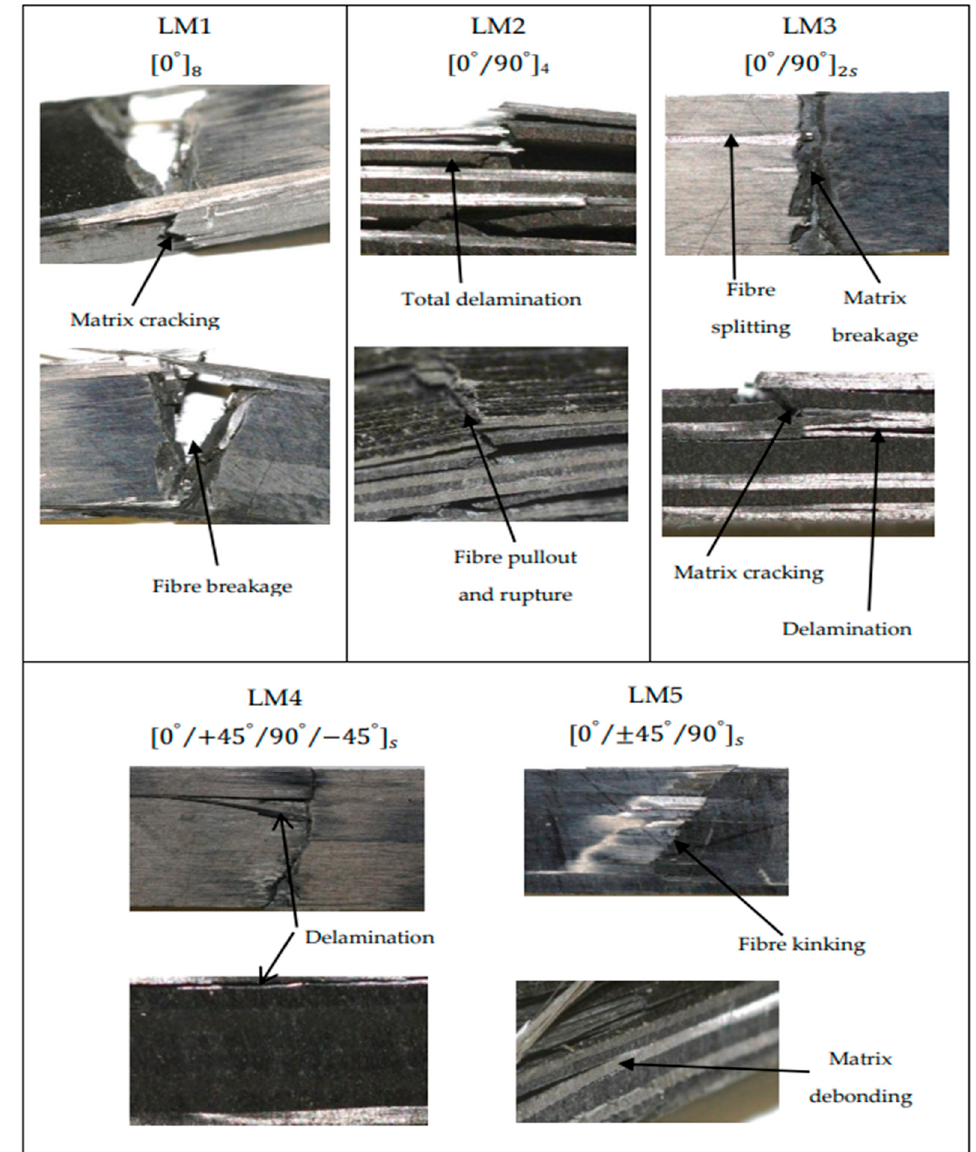
Figure 6. Micrograph image of the fractured specimen under flexural loading condition.